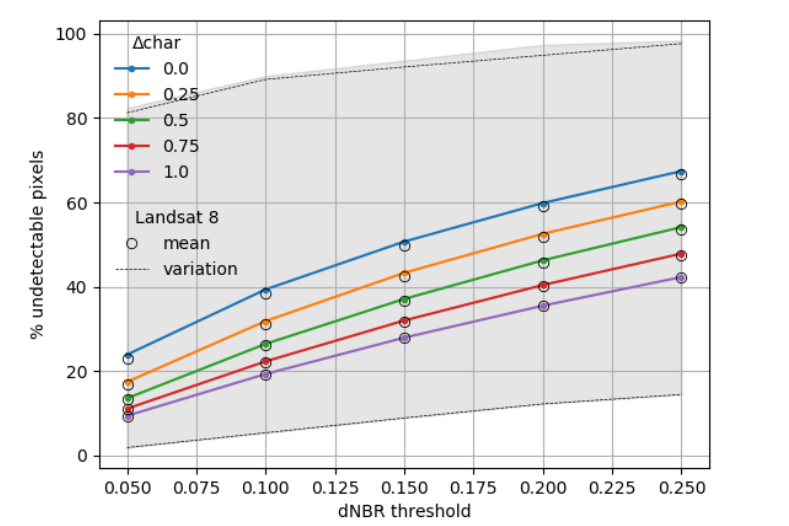
Figure A4. Percentage of undetectable burned pixels as a function of dNBR threshold and ∆ char parameter settings, park-wide for Sentinel-2A. Mean values are shown in colored lines, with total model result variation shown in gray. To compare, the results for Landsat 8 are shown in black, with mean values shown by circles and total model result variation shown by dashed lines.